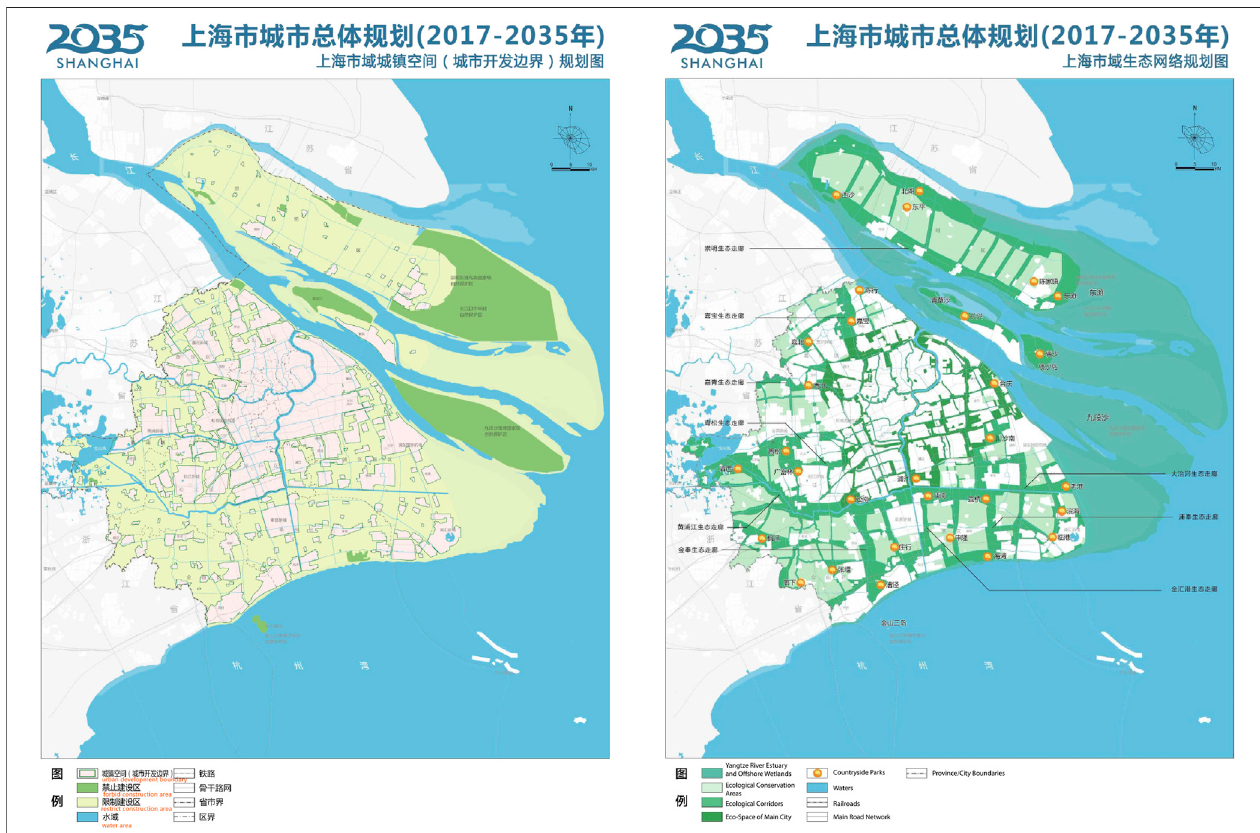
FIGURE1|(A) EcologicalProtection (Red) Lineswith buildinglimitations(Source: SPLRA, 2018a;adjustedbyauthor). (B) Eco-network plan ofShanghai(Source: SPLRA, 2018a; adjusted by author).